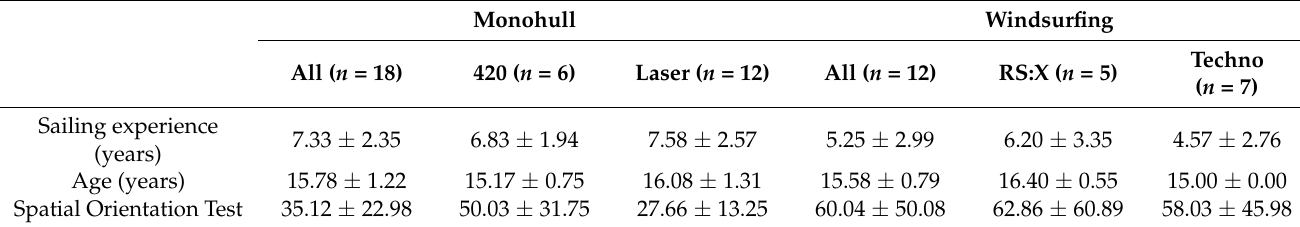
Table 1. Participants’ age, experience and score obtained in the Spatial Orientation Test by groups and classes. Monohull